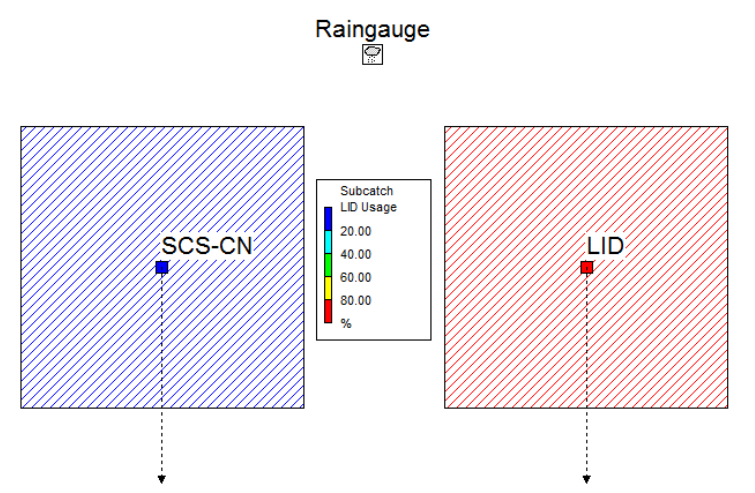
Figure 3. Defined catchments: completely pervious (blue) and 100% LID occupied (red). SCS-CN catchment characteristics were defined in the catchment properties, while LID properties were set to zero, as they are overwritten by LID properties when modelled as an entirely LID occupied catchment. The used parameters are given in Table 1. The Manning value for SCS-CN subcatchment was set to zero to avoid any delay in the runoff [41]. Initial abstraction depth was fixed at 1 mm, based on previous studies for urban areas, taking the value for traditional pavements